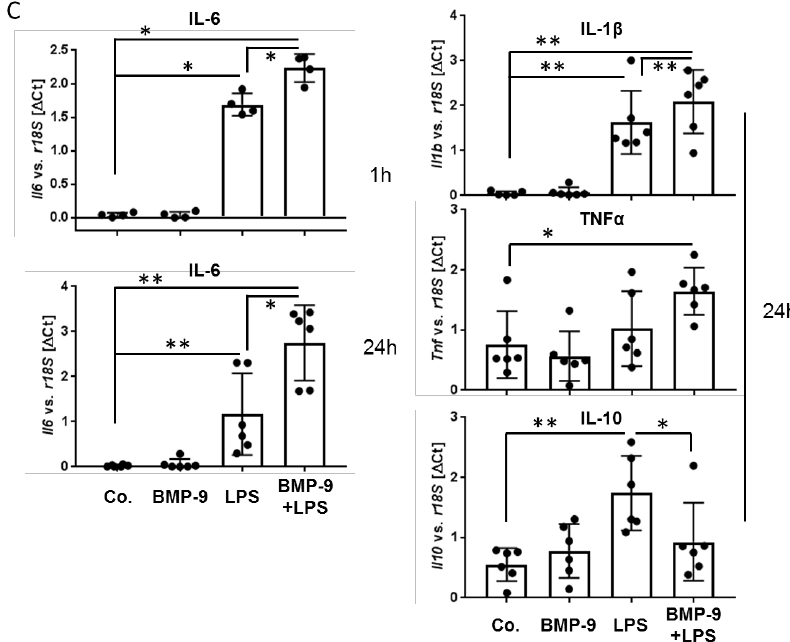
Figure 5. In macrophages stimulation with LPS plus BMP-9 reduces activation of the classical BMP / Smad-pathway but enhances inflammatory targets. ( A ) Cultured macrophages were stimulated with BMP-9 and LPS using the same experimental setup as for LSEC (Figure 3) (“24 h”) plus an additional setup with only 1 h of LPS stimulation (“1 h”). We used either a murine macrophage cell line (J774A.1; left hand graphs) or primary human monocyte-derived macrophages obtained from the blood of healthy donors (right hand graphs). Expression levels of the BMP-9 target genes Id1 and hamp ( = hepcidin) were determined by RT-qPCR. Data are expressed as average values ± SD ( ∆ Ct of target gene versus house-keeping gene). ( B ) Using the same experimental setup as in ( A ) protein lysates of J774A.1 cells were subjected to Western blot analysis. Activation of the Smad1 / 5 / 8 pathway was determined by detection of phosphorylated Smad1 and β -actin was used as loading control. One representative blot plus densitometric analyses results of n = 3–4 is shown. ( C ) In the same human macrophage samples as used in ( A ) we further analyzed the expression levels of the inflammatory mediators IL-6, IL1 β , TNF α and IL10 by RT-qPCR. p < 0.05 was considered statistically significant (*). ** indicates p < 0.01. Each dot represents an individual sample’s value.